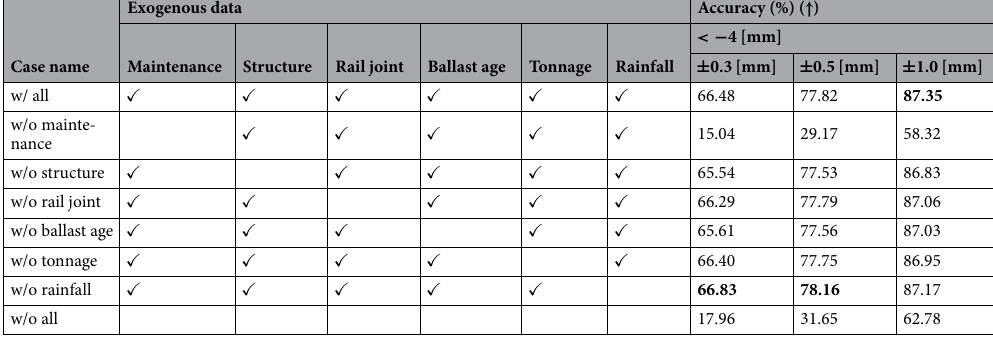
Table 10. Results of the ablation study (accuracy). The accuracy is calculated for each method with tolerance ε = 0.3, 0.5, 1.0 [mm] using data with the threshold level α = − 4 [mm].